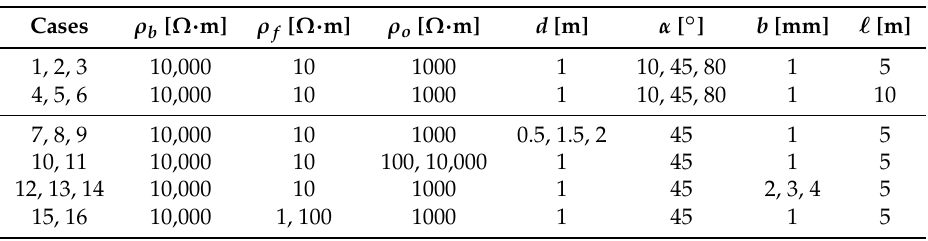
Figure 2. Diagram showing how the apparent resistivity anomaly, ρ ∗ a , is plotted as a function of the horizontal measurement position, x , and how the anomaly magnitude and width are determined. The anomaly magnitude is defined as the absolute difference between the maximum and minimum observed anomaly values, in %. The anomaly width is defined as the distance between the first and last points where the absolute anomaly value is equal to 5% of the anomaly magnitude, the latter of which is indicated by a red band in the figure. Note that the measurement position corresponds to the midpoint of the considered electrode array. Table 1. Parameter values corresponding to the 16 test cases considered in our analysis. For a description of the variables, see Figure